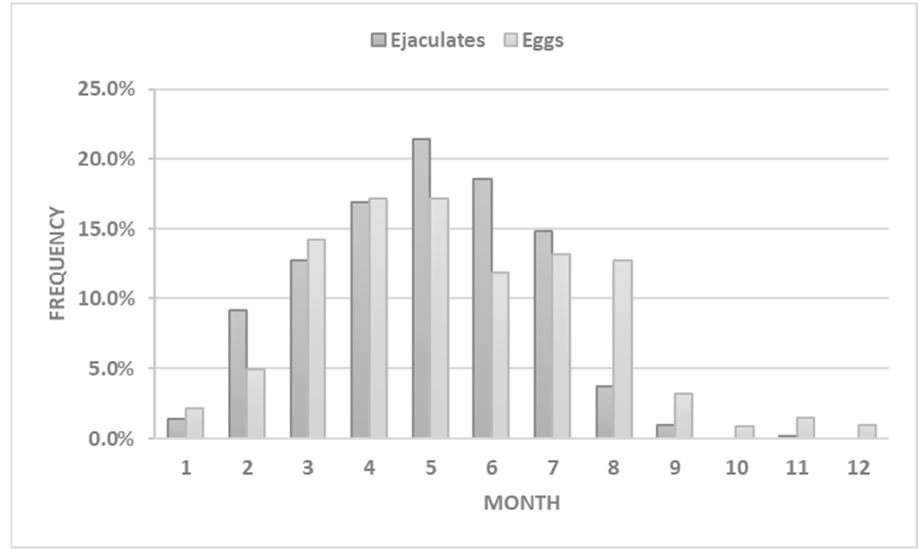
Figure A6. Artificial insemination of an Arabian bustard female.